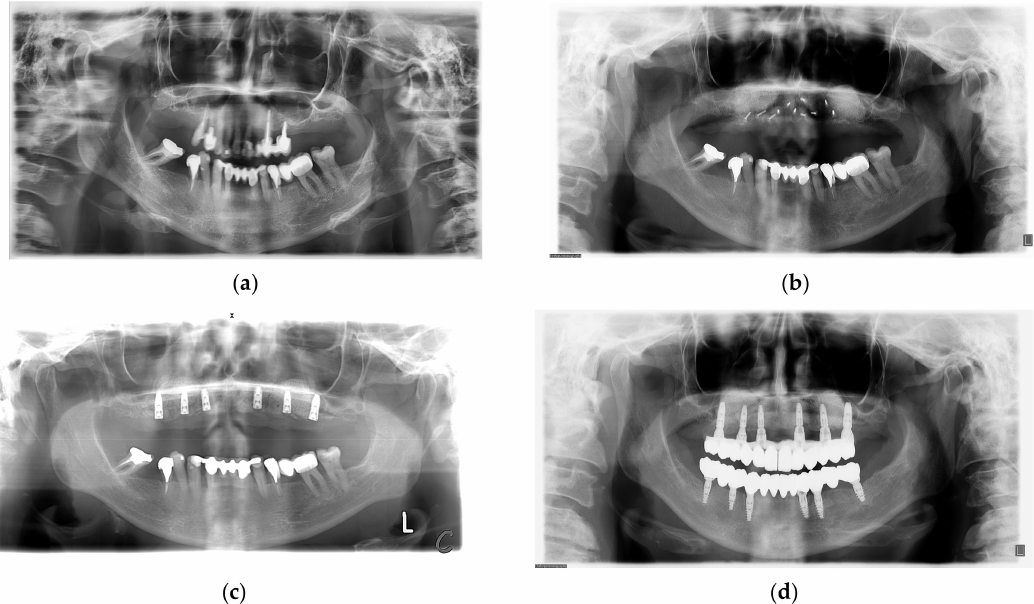
Figure 3. ( a )—Initial orthopantomographic image taken before teeth extraction; ( b )—orthopanto- mographic image after augmentation; ( c )—orthopantomographic image after implant insertion; ( d )—orthopantomographic image with implant fixture and definitive prosthetic work in place